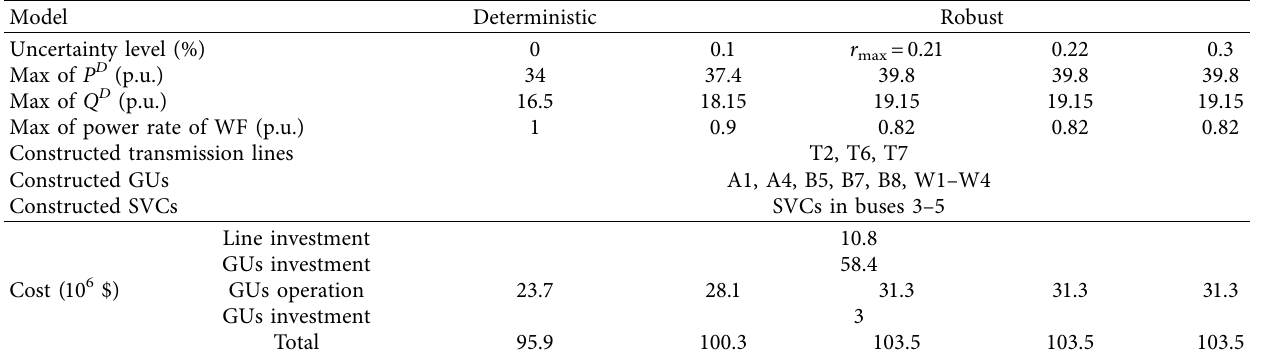
Table 4: Planning results based on the suggested GTEP method in various uncertainty values of Δϑ � 1.